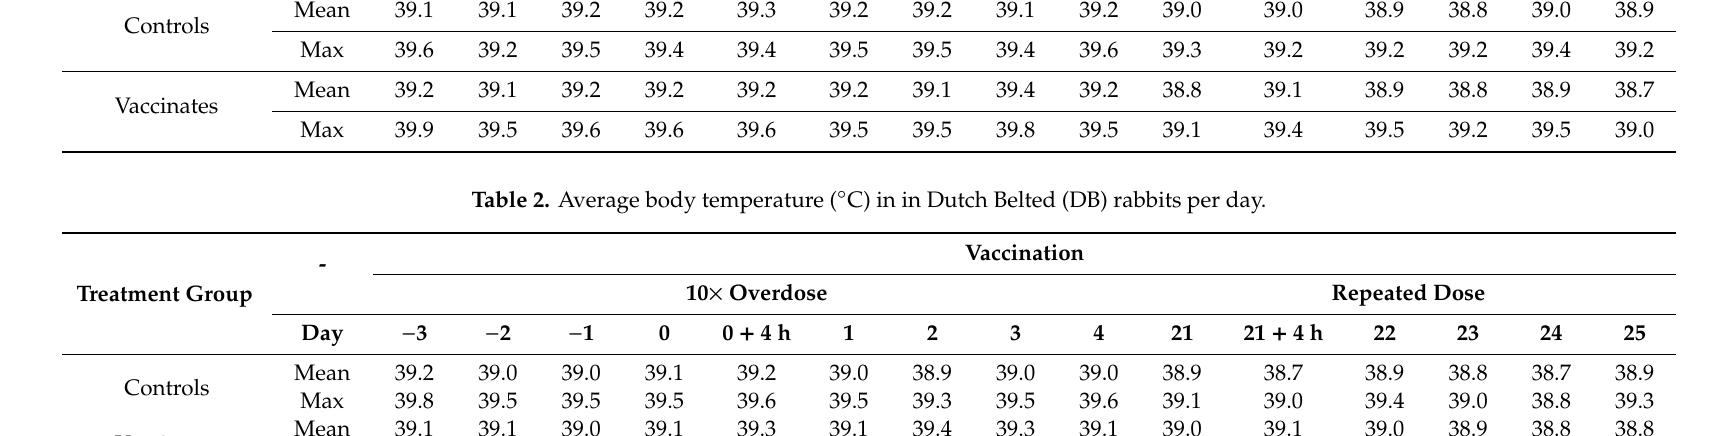
Treatment Group